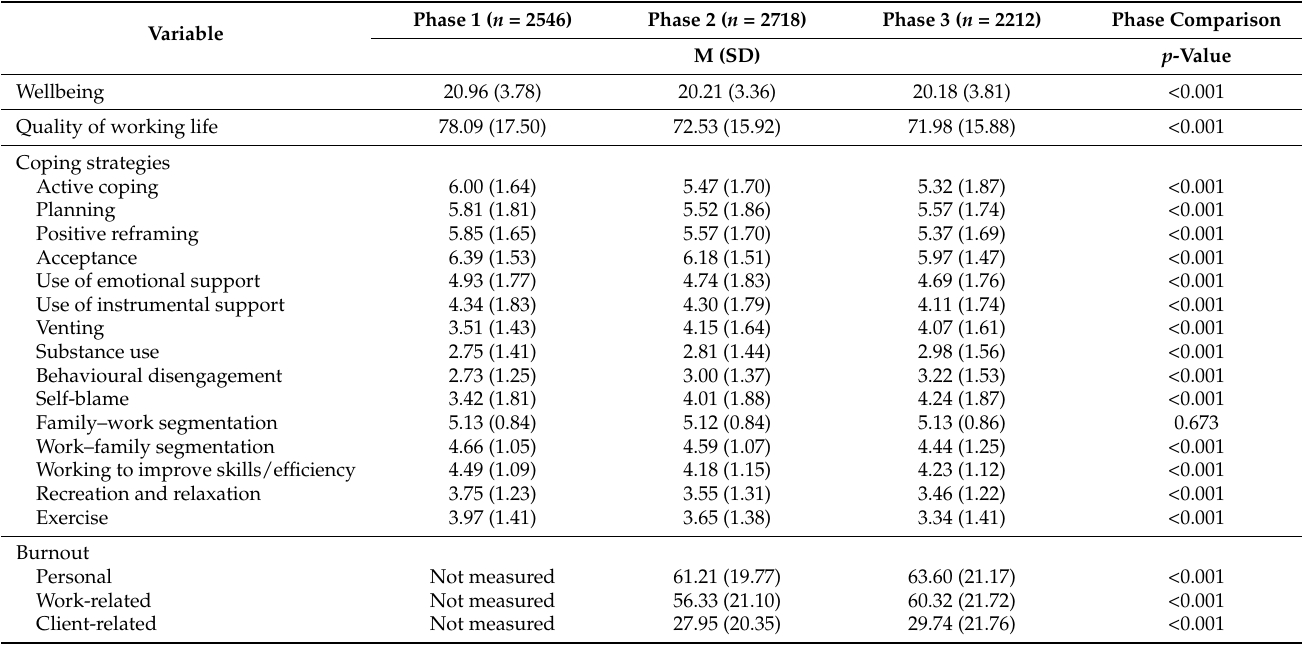
Table 3. Means and standard deviations (in brackets) for wellbeing, work-related quality of life (WRQoL), coping strategies and burnout across study